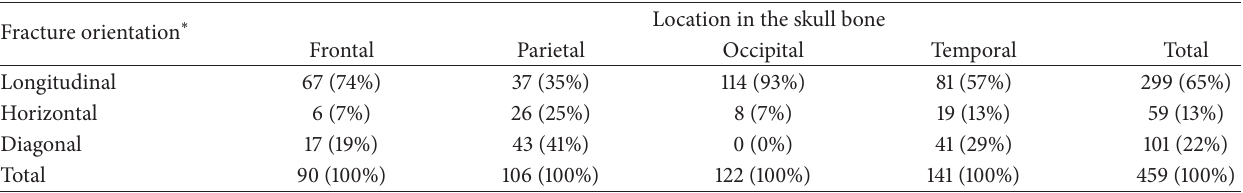
Table 2: The locations and orientations of linear fractures detected on head CT or skull